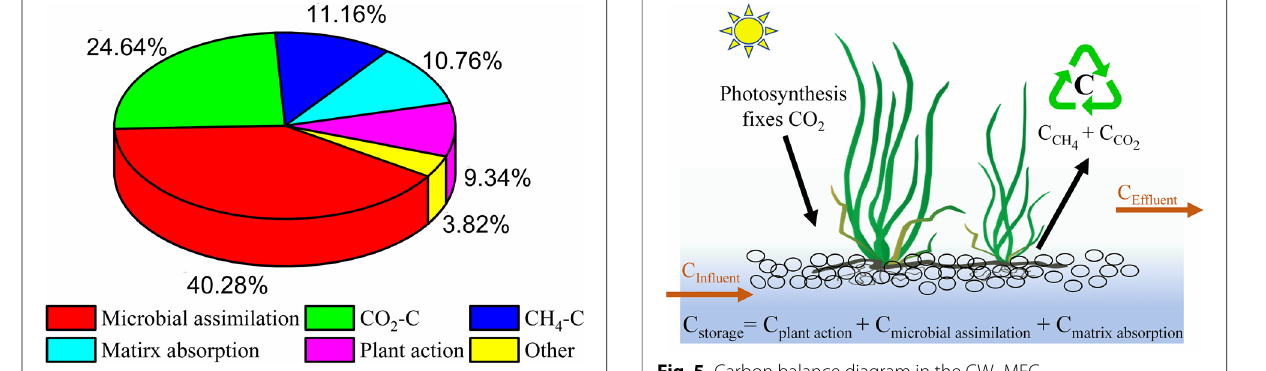
Fig. 4 Ultimate fate of carbon in the carbon cycle of the CW–MFC Fig. 5 Carbon balance diagram in the